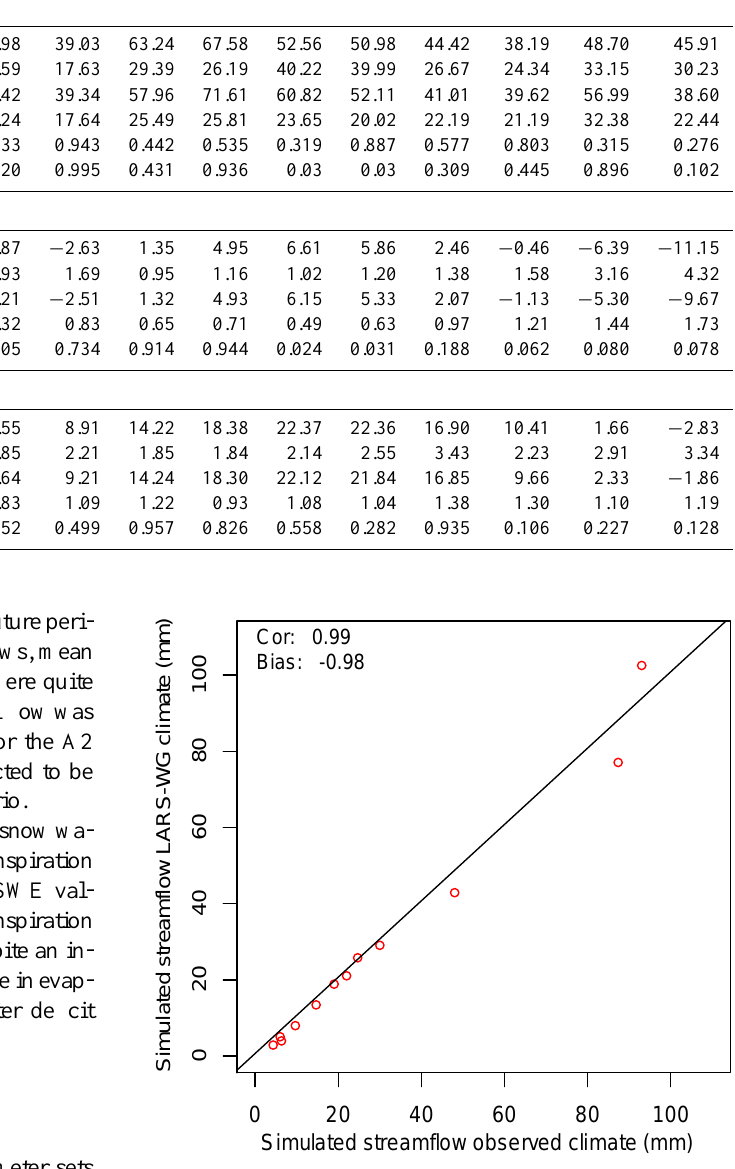
Fig. 7. Comparison of mean monthly streamflow simulated using daily observed climate forcing with mean streamflow simulated us- ing LARS-WG-generated daily climate